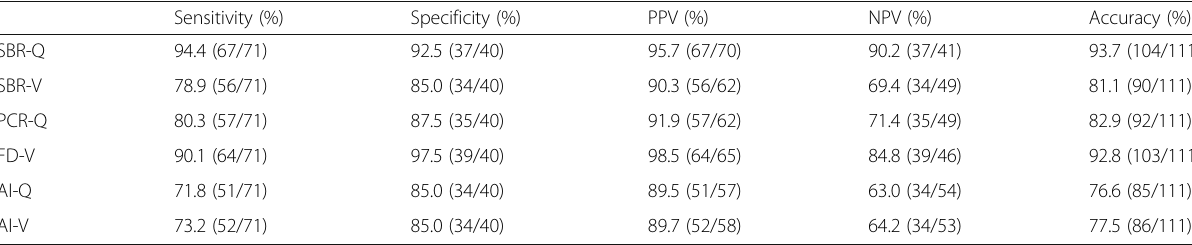
Table 2 Sensitivity, specificity, PPV, NPV, and accuracy of the six